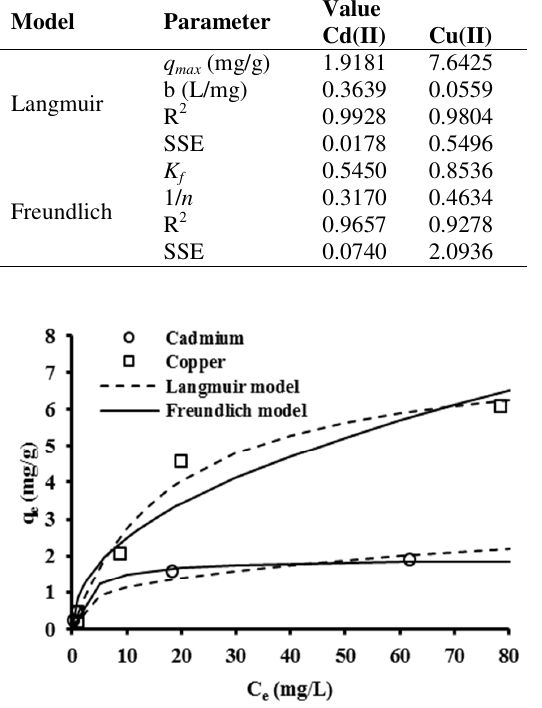
Fig. 3. Isotherms models for cadmium and copper ions sorption onto